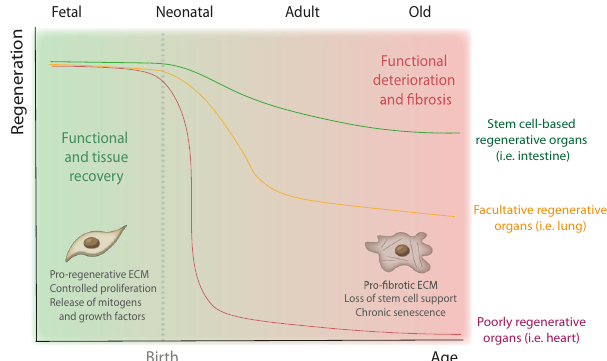
homeostasis and respond to injury in a pro-regenerative fashion.